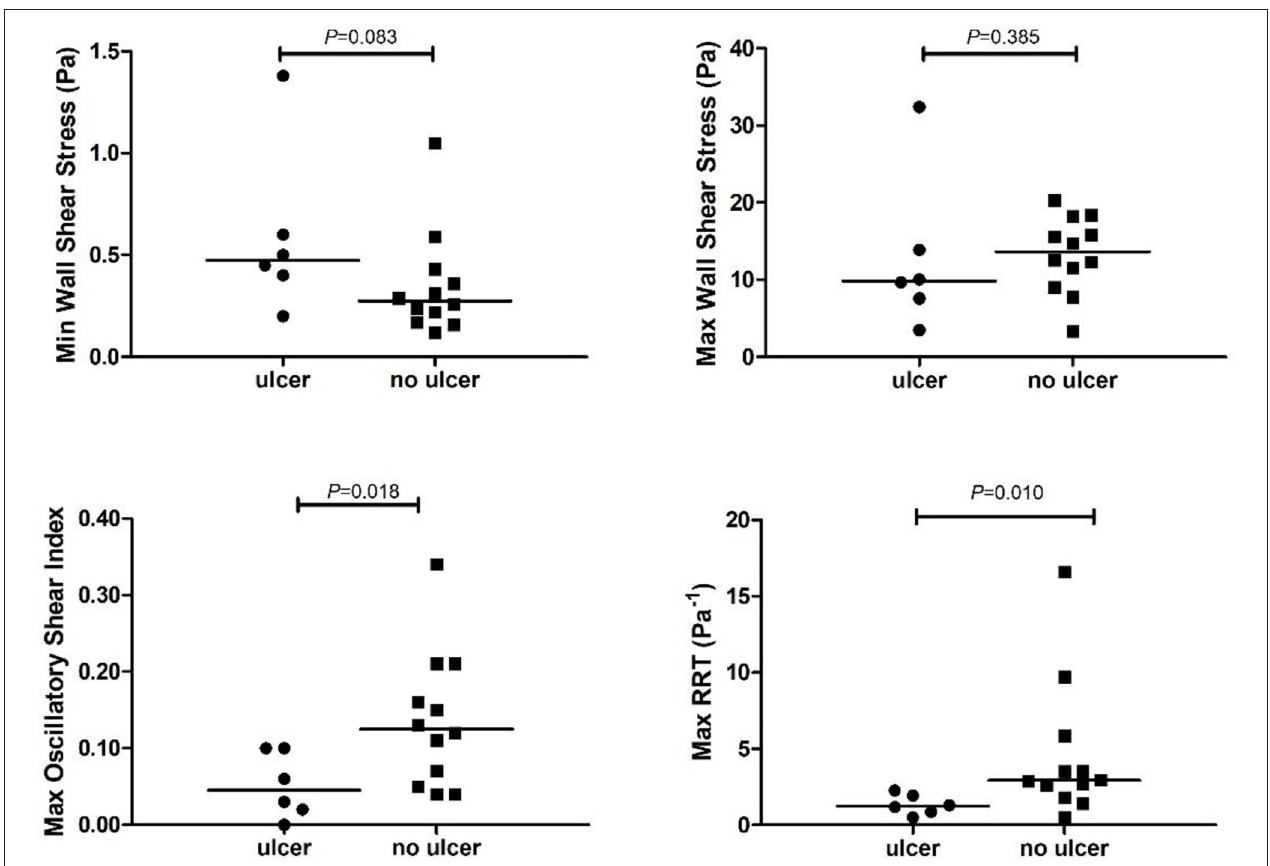
FIGURE 3 | Time varying wall shear stress at the plaque that developed an ulcer (ulcer) vs. the control plaques (no ulcer). RRT, relative residence time. Maximum or minimum time varying wall shear stress values are calculated at the plaque with ulcer or at the plaque without ulcer (no ulcer).